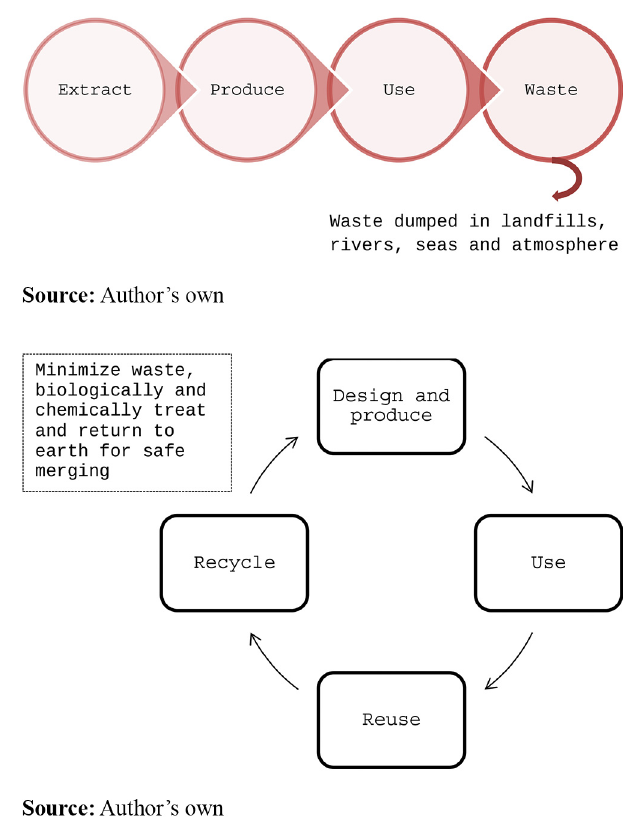
Figure 5. Paradigm of